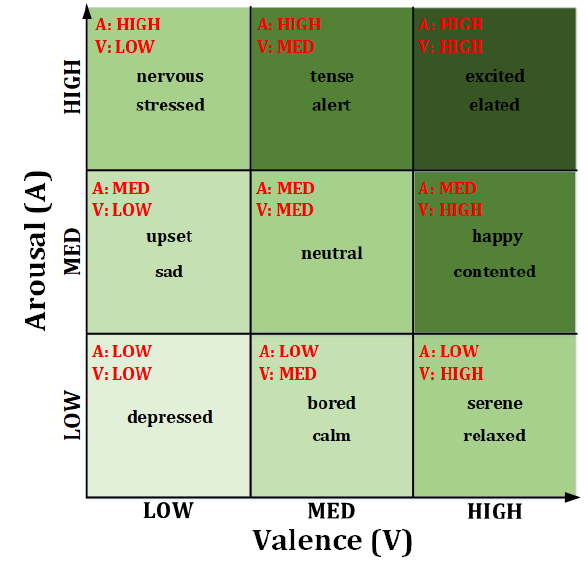
Figure 1. Classification of the different affective states according to Arousal and Valence. Information obtained from Posner et al.